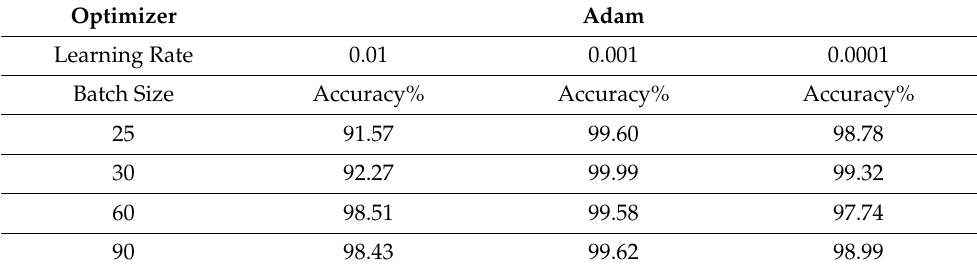
Table 4. Experimentation results of parameter tuning for the Kaggle hand posture